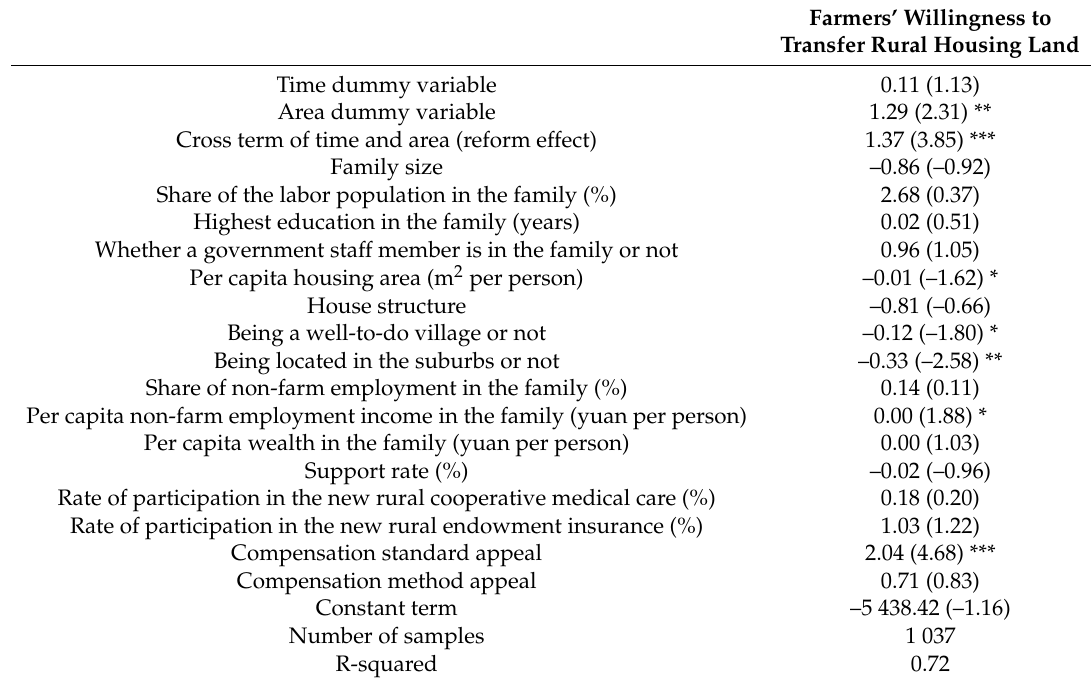
Table 3. Estimates of the difference-in-difference (DID) regression